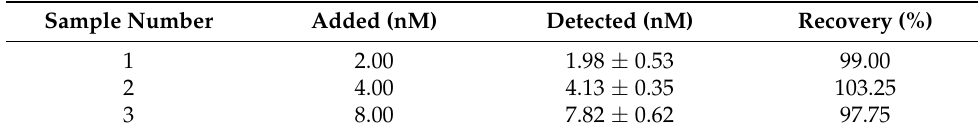
Table 1. Recovery experiments of OTA determination in red wine samples.